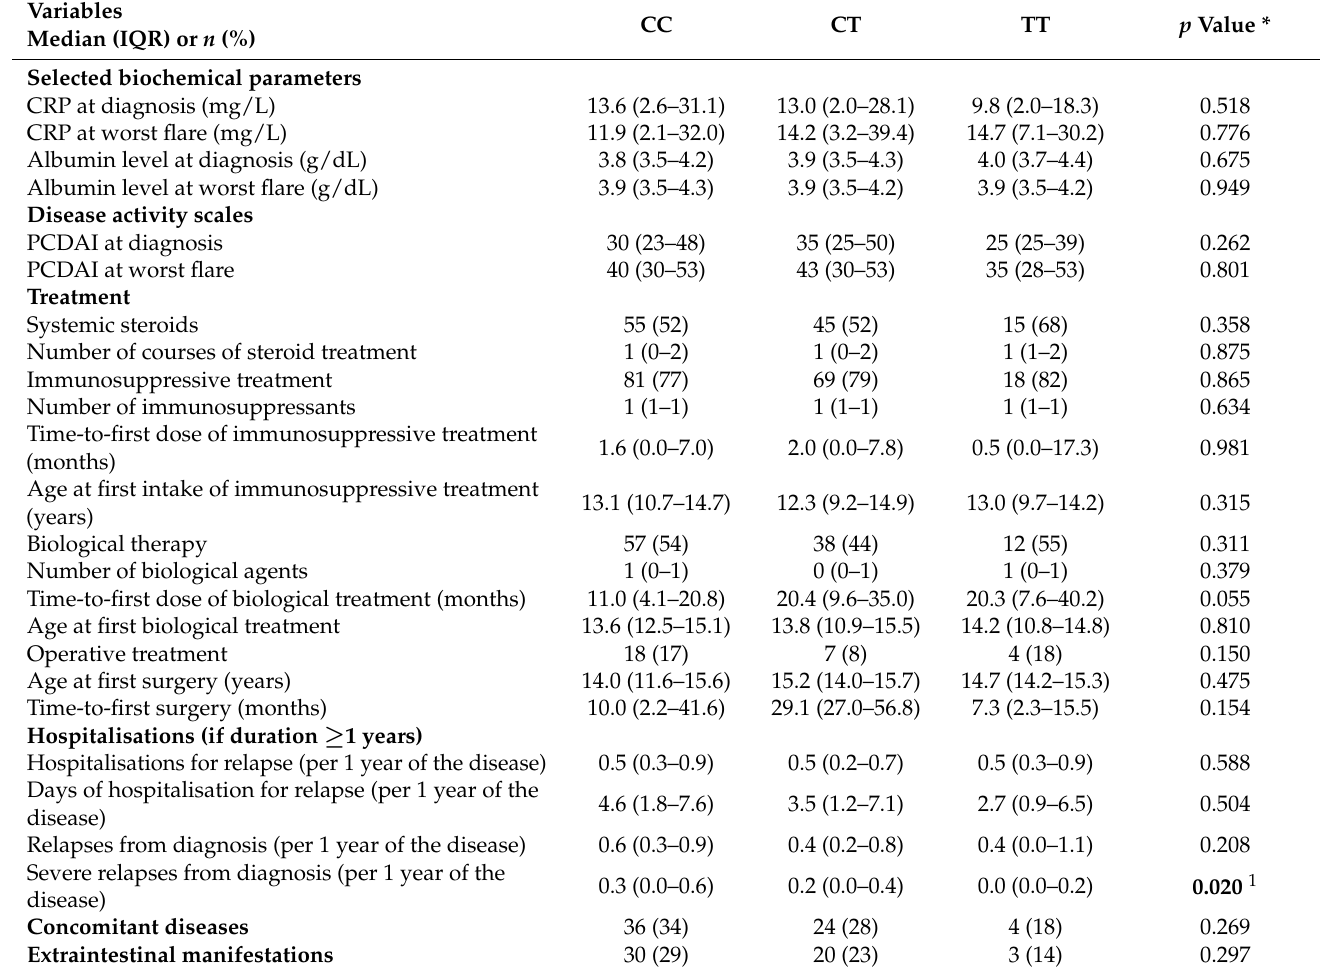
Table 4. Association between DMBT1 rs2981745 genotypes and CD characteristics.